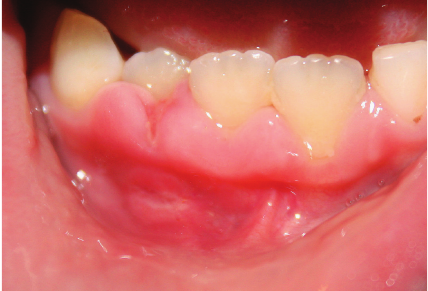
Figure 3: Nodular swellings of the interdental papillae between the right permanent mandibular central and lateral incisors and pri- mary canine. An ulceration of the free gingival margin between the incisors is seen. Also noted is a linear ulceration with hyperplastic margins involving the alveolar